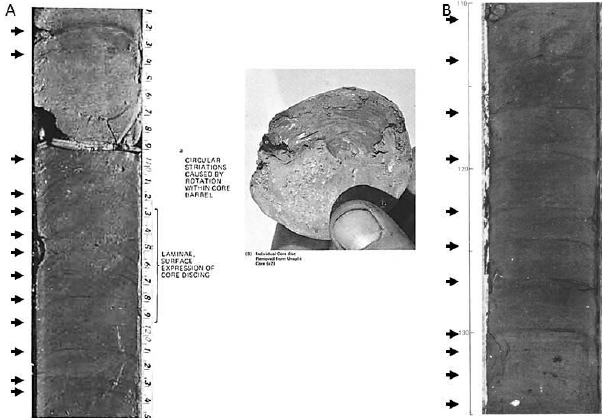
Figure 2. (a) “Core discing” as illustrated by Kidd (1978) from DSDP Site 376 (Florence Rise, Mediterranean Sea west of Cyprus). (b) “Drilling laminations” illustrated by Leggett (1982) from DSDP Site 488 (Middle America Trench off Mexico, eastern Pacific